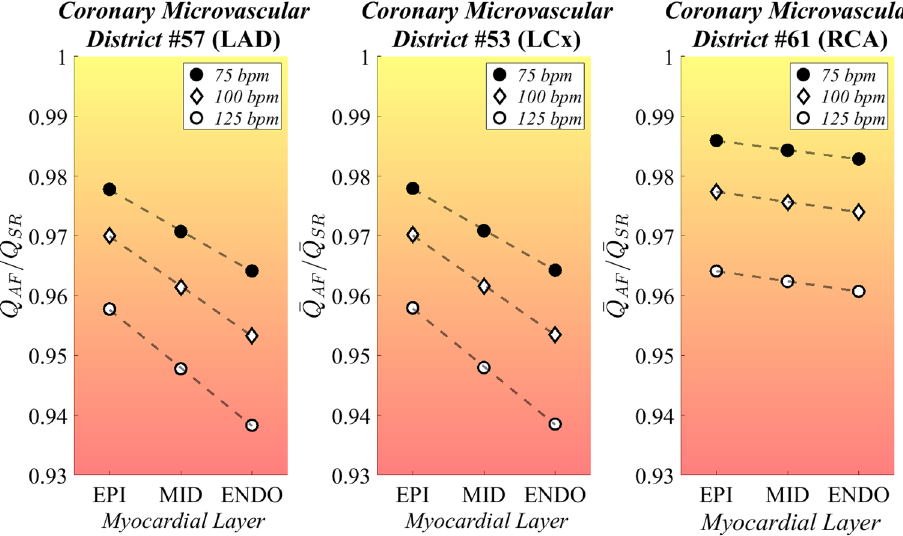
Figure 5. Dot plot reporting Q AF / Q SR at each simulated frequency across the myocardial layers, in three exemplificative coronary microvascular districts. Rate-specific regression lines (dashed lines) are also reported. LAD left anterior descending artery, EPI subepicardium, MID midwall, ENDO subendocardium, LCx left circumflex artery, RCA right coronary